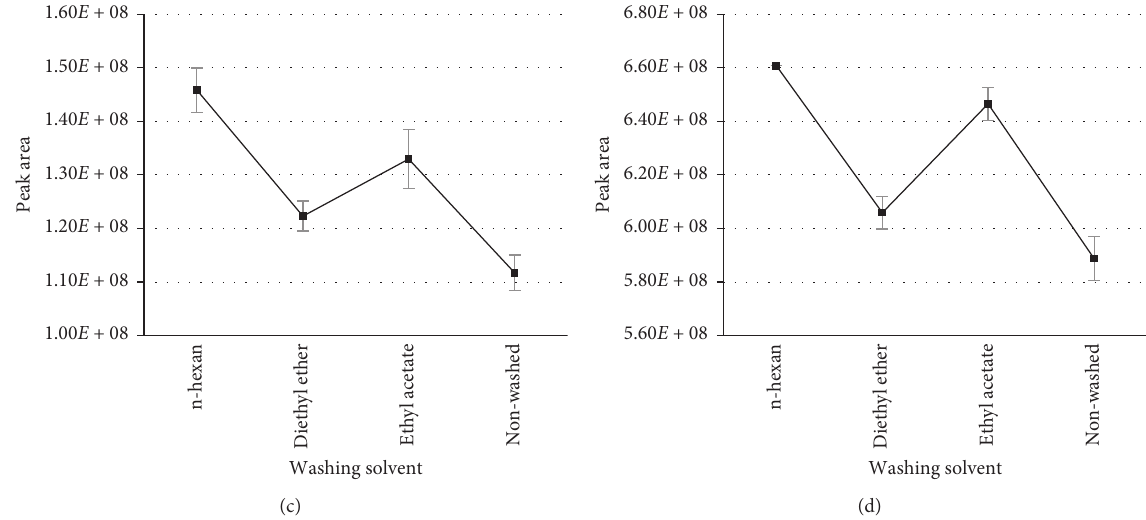
Figure 3: Comparison of the intensity of four representative PDE-5i after cleaning with three different solvents. (a) Acetildenafil. (b) Acetaminotadalafil. (c) Hydroxyvardenafil. (d)